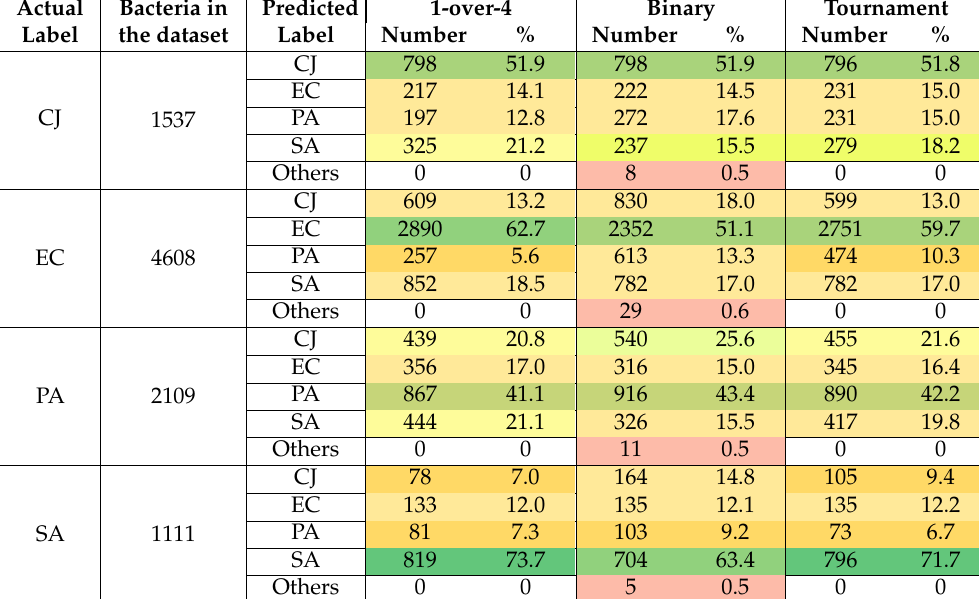
Table 3. Comparison of the individual scores of each type of bacterium in isopropanol for the Table 1. over-4, binary, tournament. The cell background colour varies from red to green through orange and yellow depending on the percentage of bacteria correctly identified. The colourbar is not linear. Red corresponds to percentages below 5%, orange around 10%, yellow around 20% and green above 30%. Actual Bacteria in Predicted 1-over-4 Binary